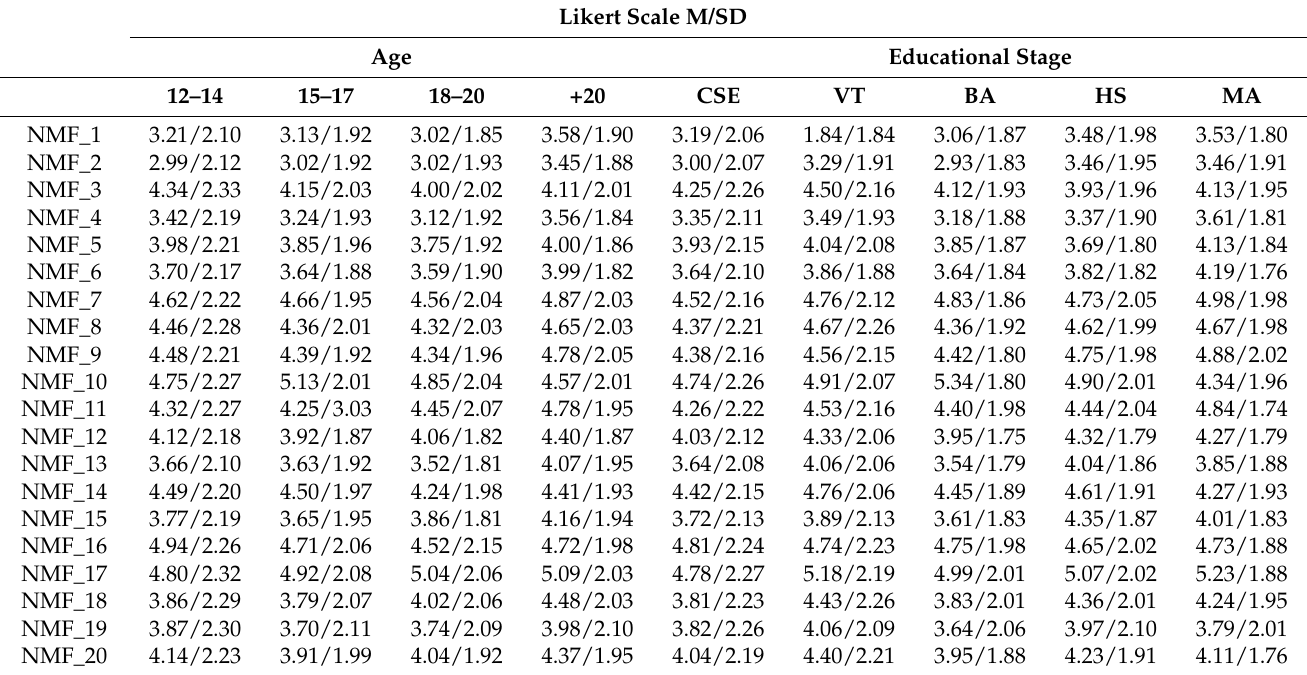
Table 1. Descriptive of averages by age and educational